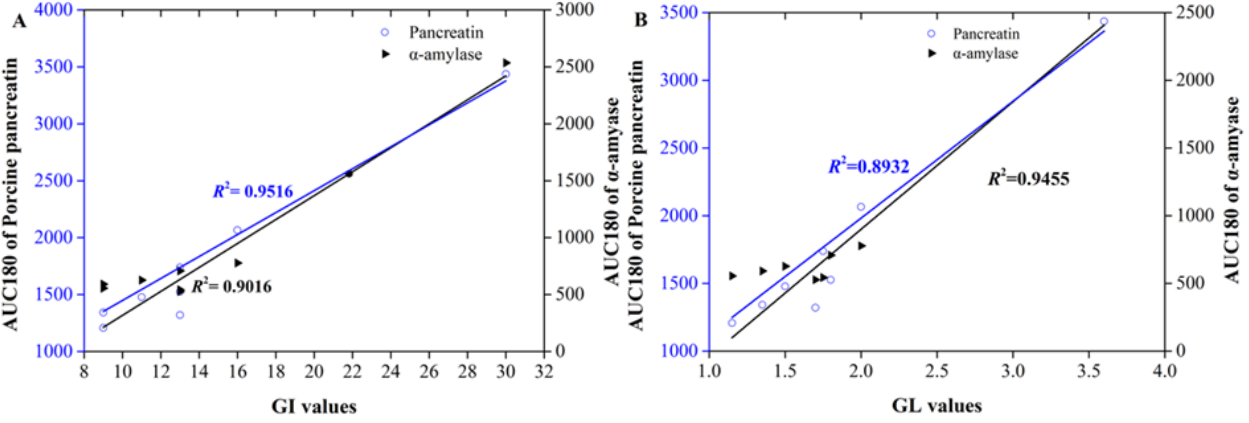
Figure 5. Linear regression analysis of the correlations between the AUC 180 and the GI ( A ) and GL ( B ) values when digesting using either porcine pancreatin or pure α -amylase ( n = 8)